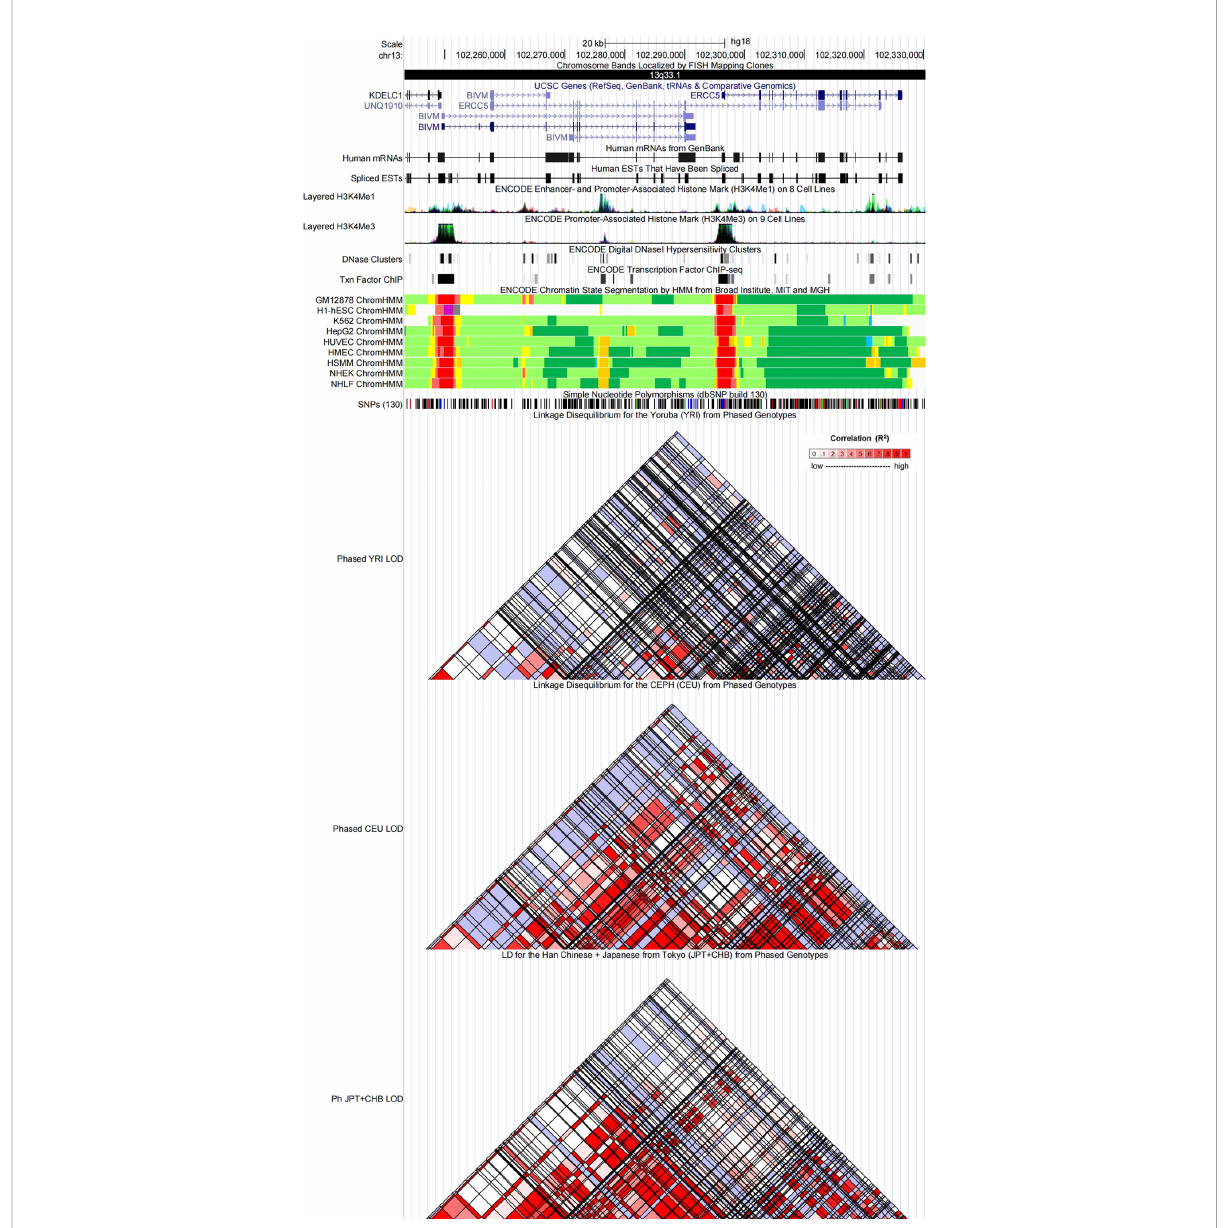
FIGURE 4 Evidence from the ENCODE data for the regulatory function of variants in 13q33.1 using the UCSC Genome Browser. The plot represents 13q33.1 within a 20-kb window centered on the ERCC5 gene region. Tracks (from top to bottom) in each of the plots are Genome Base Position, Chromosome Bands, UCSC Genes, Human messenger RNAs from GenBank, Human expressed sequence tag (ESTs) That Have Been Spliced, ENCODE Enhancer and Promoter-Associated Histone Mark (H3K4Me1) on 8 Cell Lines, ENCODE Promoter-Associated Histone Mark (H3K4Me3) on 9 Cell Lines, ENCODE Digital DNaseI Hypersensitivity Clusters, ENCODE Transcription Factor ChIP-seq, ENCODE Chromatin State Segmentation by Hidden Markov Model (HMM) from Broad Institute (bright red, active promoter; light red, weak promoter; purple, inactive/poised promoter; orange, strong enhancer; yellow, weak/poised enhancer; blue, insulator; dark green, transcriptional transition/elongation; light green, weak transcribed; gray, polycomb-repressed; light gray, heterochromatin/low signal/ repetitive/copy number variation), Simple Nucleotide Polymorphisms (dbSNP build 130), Linkage Disequilibrium for the Yoruba (YRI) from Phased Genotypes, Linkage Disequilibrium for the CEPH (CEU) from Phased Genotypes and LD for the Han Chinese + Japanese from Tokyo (JPT+CHB) from Phased